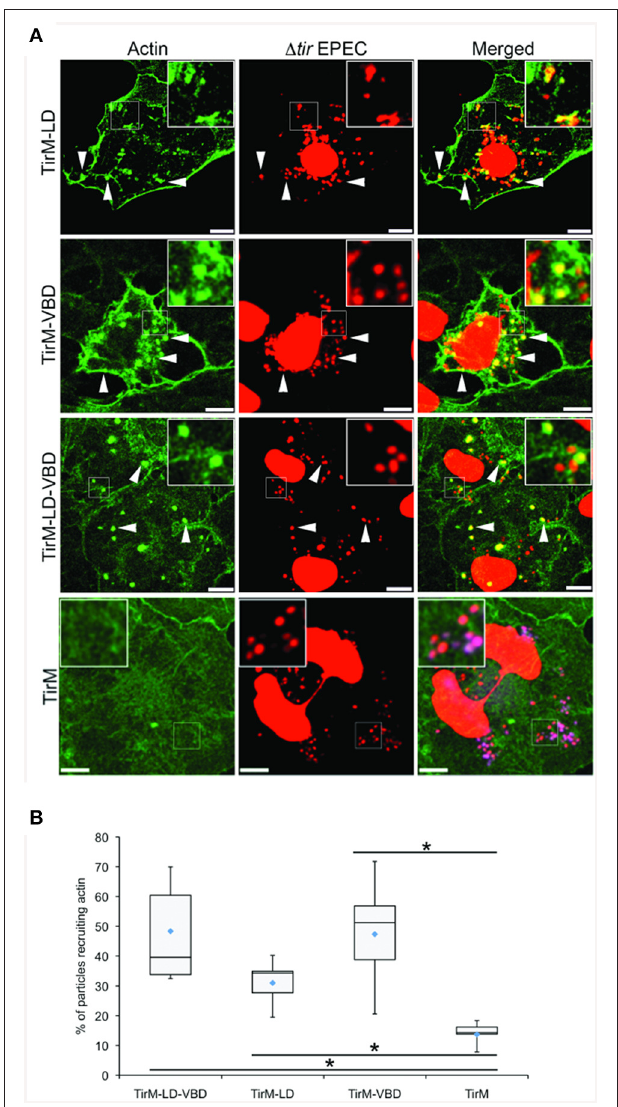
FIGURE 9 | The LD-VBD induces robust actin recruitment. (A) Cos7 cells transfected with the plasmid encoding LD-VBD were infected with 1 tir EPEC to induce clustering of the proteins. Transfected cells were identified by the capacity to facilitate bacteria attachment. The white arrowheads indicate colocalization of actin with adhered 1 tir EPEC. Actin (green) and bacteria (false-colored red) were visualized with phalloidin or DAPI, respectively. Scale bars: 10 µ m. (B) Adhered EPEC able to recruit actin were enumerated and data represented as box and whisker plot. Data compiled from three independent experiments. Plot shows range (statistical outliers excluded), first and third quartiles, and overall median (horizontal line). Diamonds indicate means. A range of 300–680 particles were counted. The asterisk and bars indicate significance difference between specific groups (One-way ANOVA, Tukey’s post-hoc test, P < 0.00001 ). For comparison, previously quantified data for the LD domain alone or the VBD domain alone actin was included.